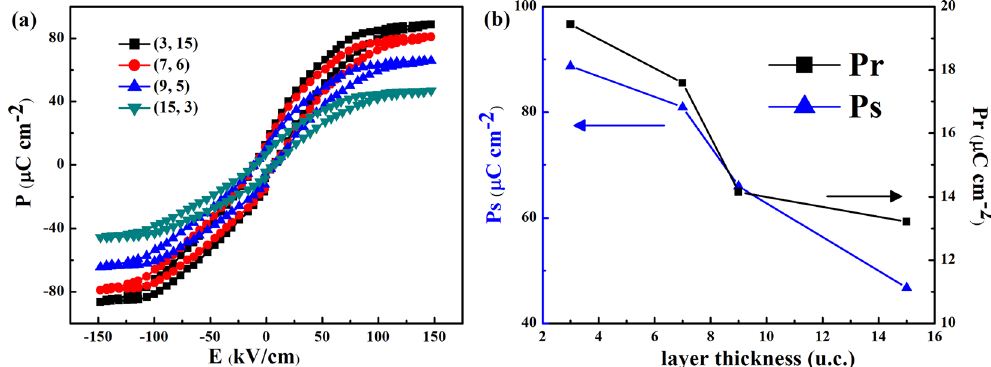
Figure 4. Evolution of ferroelectricity with layer periodicity. ( a ) P-E hysteresis loops for (3, 15), (7, 6), (5, 9) and (15, 3) SLs measured at 30 K at the frequency of 2 kHz. ( b ) Comparison of the thickness dependence of P s and P r for various SLs at T = 30 K. Pr and Ps represent the remnant polarization and the saturation polarization, respectively.